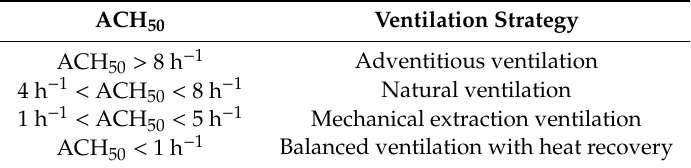
Table 1. Relationship between ventilation strategies and ACH 50